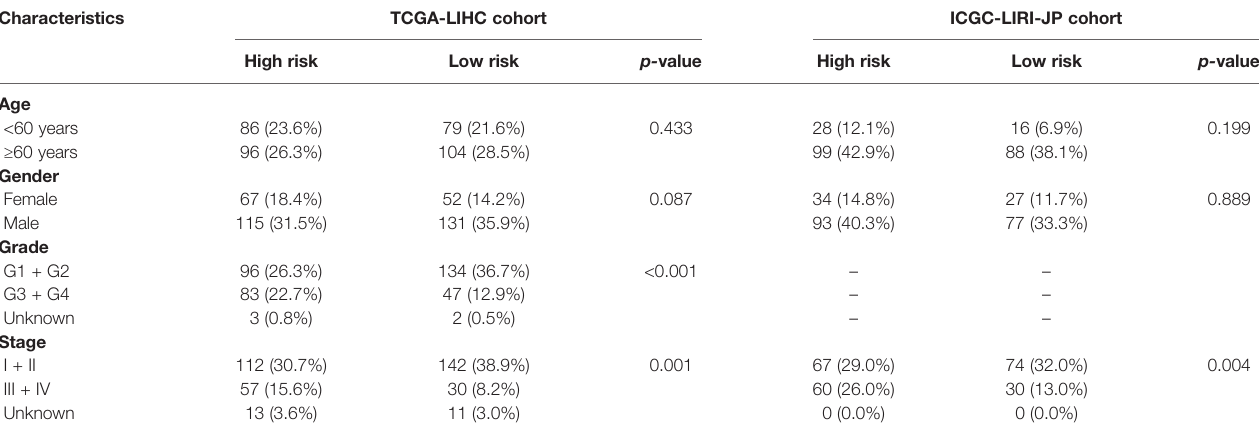
TABLE 2 | Baseline characteristics of the patients in different risk groups.